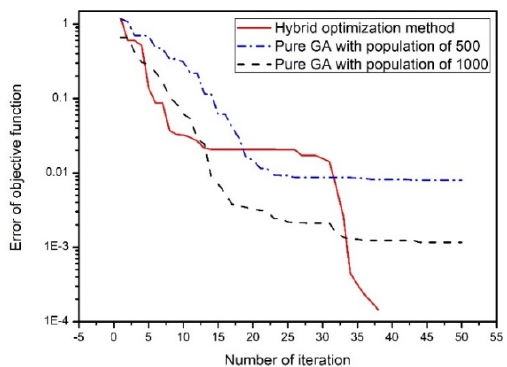
Figure 9. Error of objective function of the microstrip interdigital capacitor. The logarithmic coordinates are used. Solid line represents the error of Hybrid GA–Powell’s method. Dash-dot line represents error of pure GA with population of 500. Dash line represents error of pure GA with population of 1000.